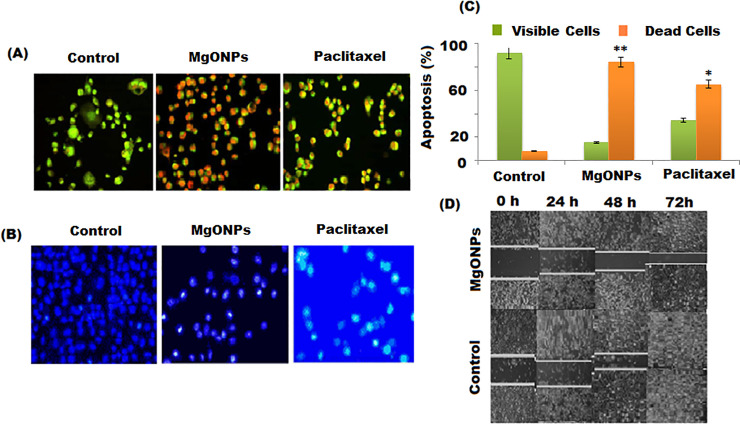
Antiproliferative effect of MgONPs at its IC50 in MCF-7 cells as depicted by (A) AO/EtBr double staining (B) quantification of apoptotic population (C) DAPI staining (D) Wound healing showing inhibition of cellular migration in MgONPs treated group of MCF-7 cells.